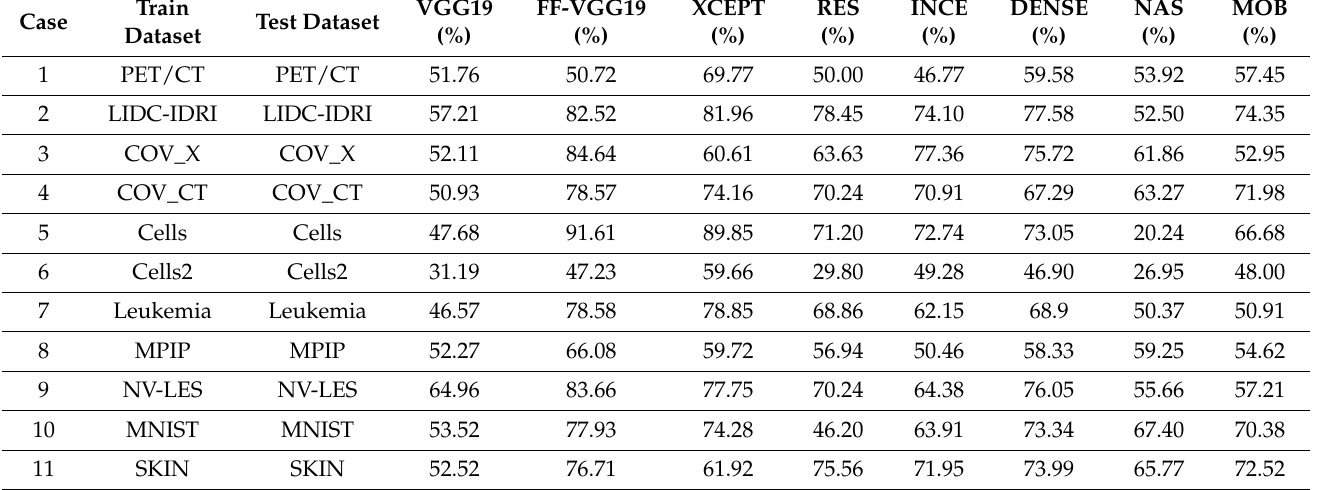
Table 7. Classification accuracy of the CNNs when training from scratch. The table columns refer to the various networks employed for the classification. XCEPT refers to Xception, RES refers to ResNet, INCE refers to InceptionV3, DENSE refers to DenseNet, NAS refers to NasNet, and MOB refers to MobileNet. The evaluation is based on 10-fold